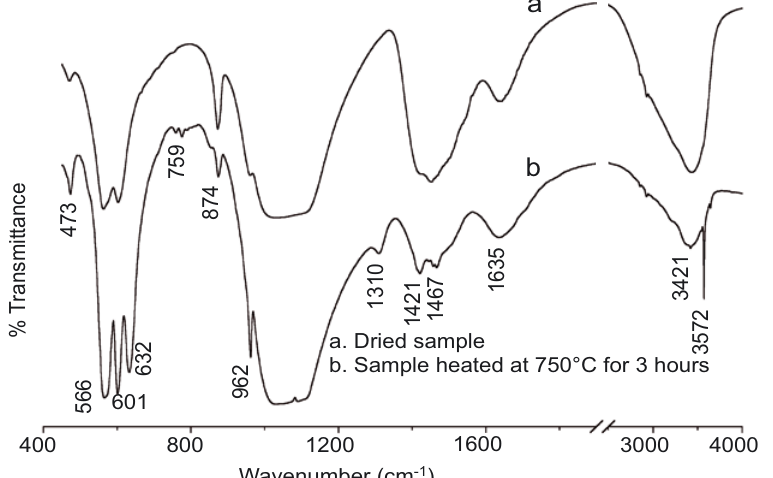
Figure 8. FT-IR spectra of the dried and the heated